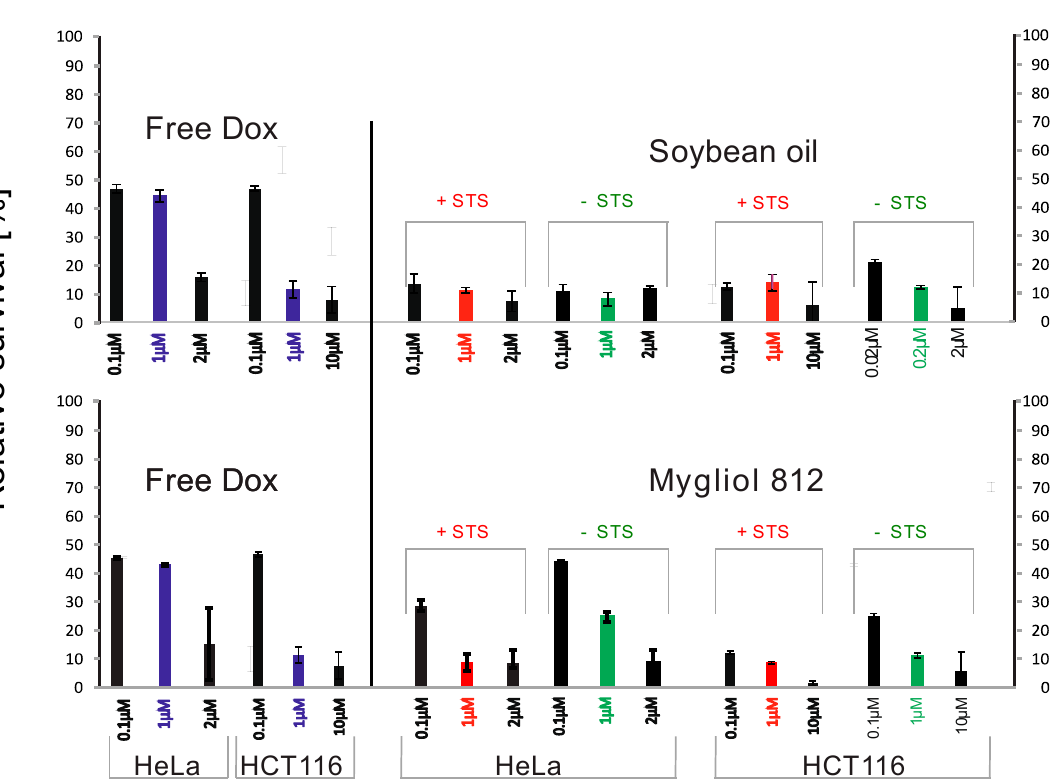
Figure 5. The survival of HeLa cells is reduced the strongest with Dox-loaded and STS-containing soybean oil-based carrier systems. Shown here are medium-corrected, relative survival rates of either HeLa or HCT116 cells in response to Dox. To account for the eventuality of cytotoxic properties of empty carrier systems, we added comparable amounts of empty carriers as were needed to the delivery of the concentration of Dox (not shown). Red bars indicate 1 µ M free Dox, and violet bars indicate 1 µ M Dox delivered via carrier systems. The results for soybean oil-derived formulations are shown in the top panel, whereas and the results for the corresponding Mygliol 812-derived formulations are shown in the bottom panel.